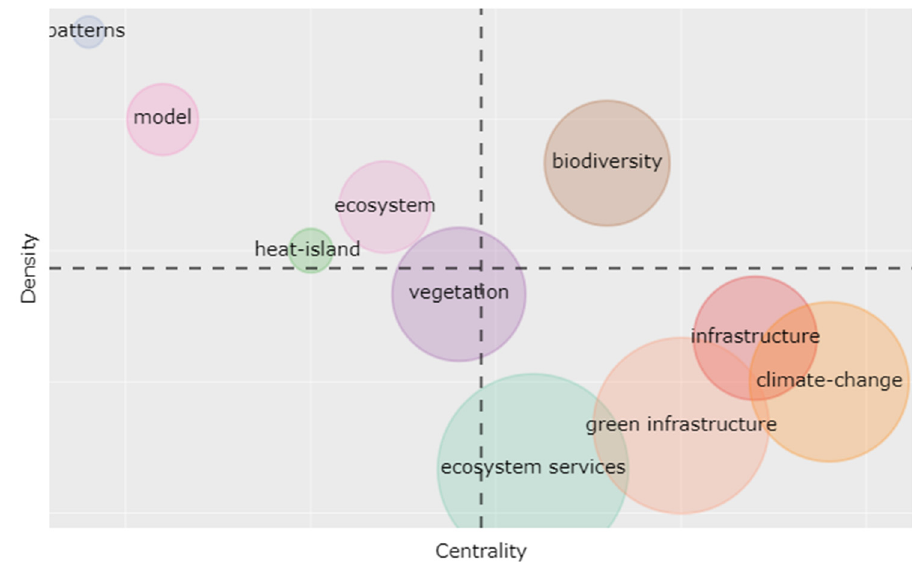
Figure 9. Thematic Map by Keywords Plus. Source: Biblioshiny. Own compilation.